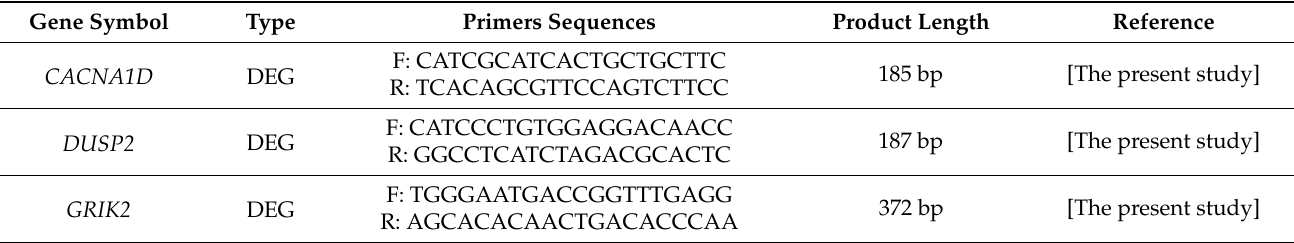
Table 3. Primers used for the PCR and qPCR validations of RNA-Seq data analyses results. Gene